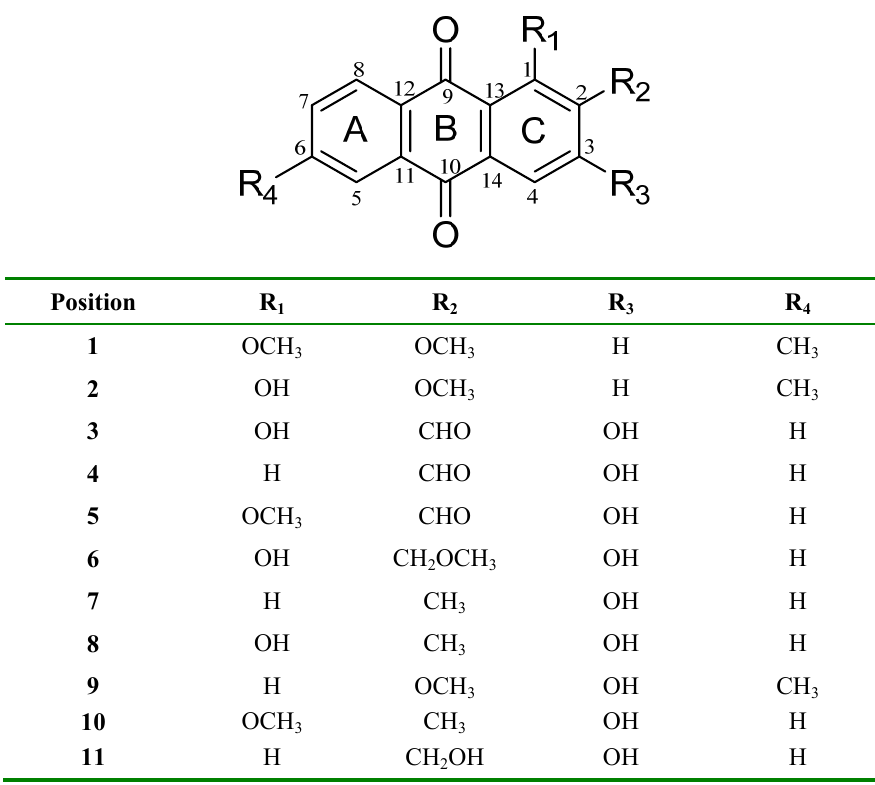
Figure 1. Anthraquinones 1-11 , isolated from roots of R. elliptica